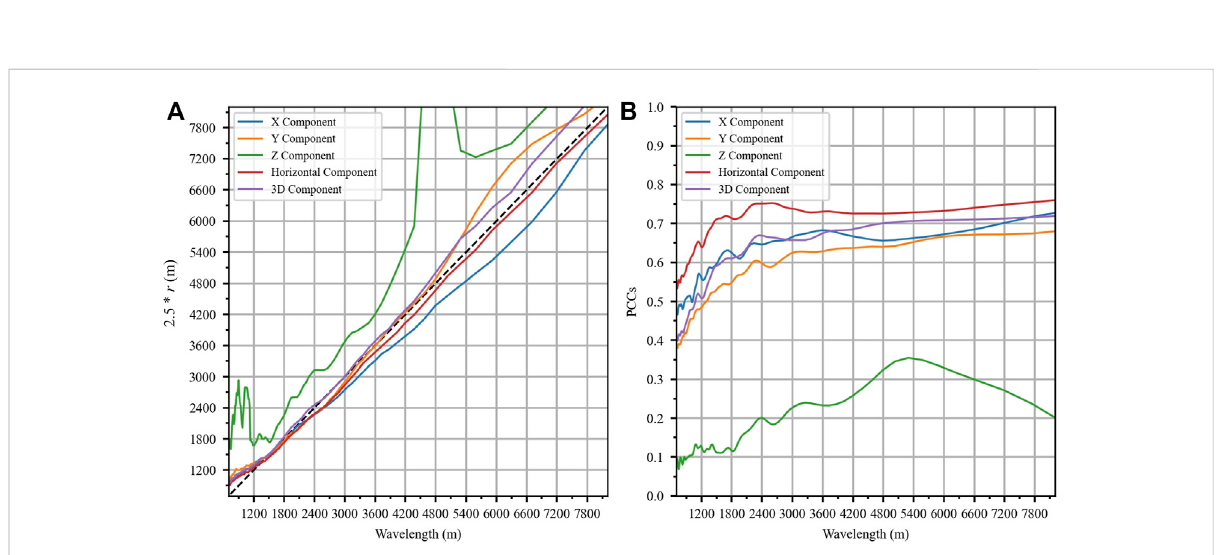
FIGURE 8 The relationship between AF ( f ) and H r ; (A) The relationship between wavelength and r when AF ( f ) and H r is best correlated; (B) The maximum PCCsoverdifferentseismicwavelengths.Solidlinesofdifferentcolorsin (A) and (B) correspondtodifferentcomponents(seelegendintheupperleft for details), and the black dashed line in (A) indicates that the value of the abscissa is equal to the